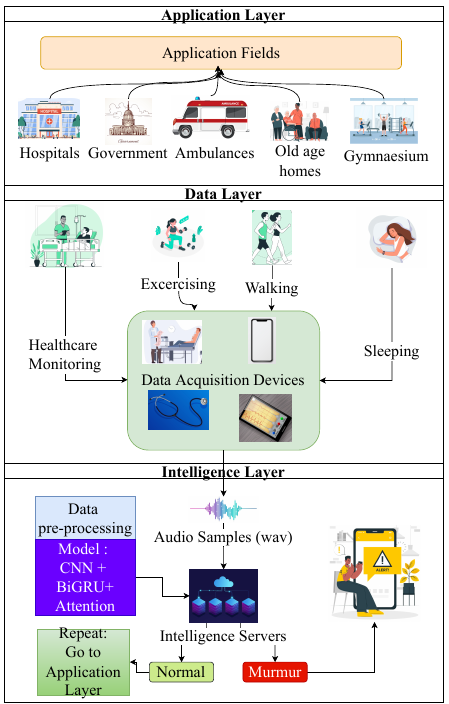
Figure 1. The proposed